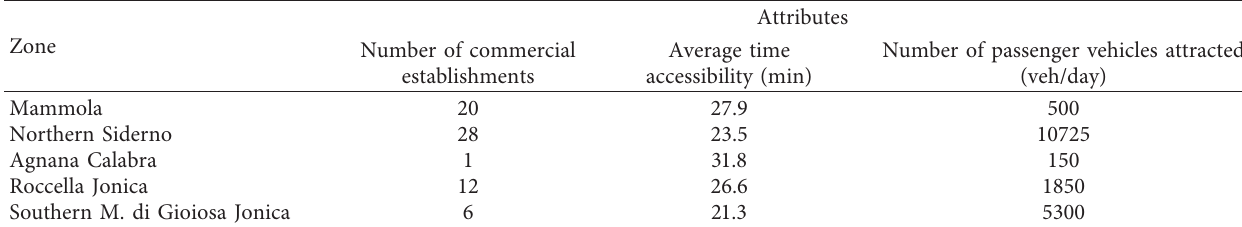
Table 10: Values of model attributes for the selected